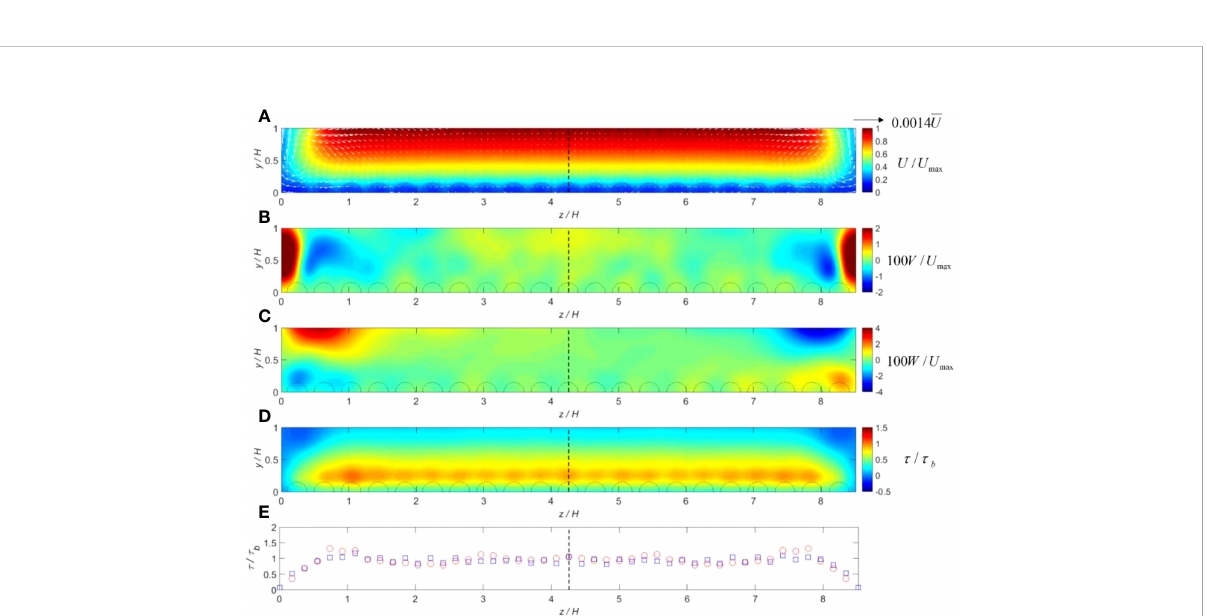
FIGURE 8 (A – E) Cross-sectional distributions of hydrodynamic parameters computed for fl ow condition 2 (shallow depth: Re = 17,500) including the roughness elements: normalized mean (A) streamwise velocity with vector fi eld; (B) vertical velocity; (C) lateral velocity; (D) shear stress; and (E) measured and computed bed shear stress (circles: exp data; squares: SPH). The dashed semicircles at the bottom of each panel represent the rough bed